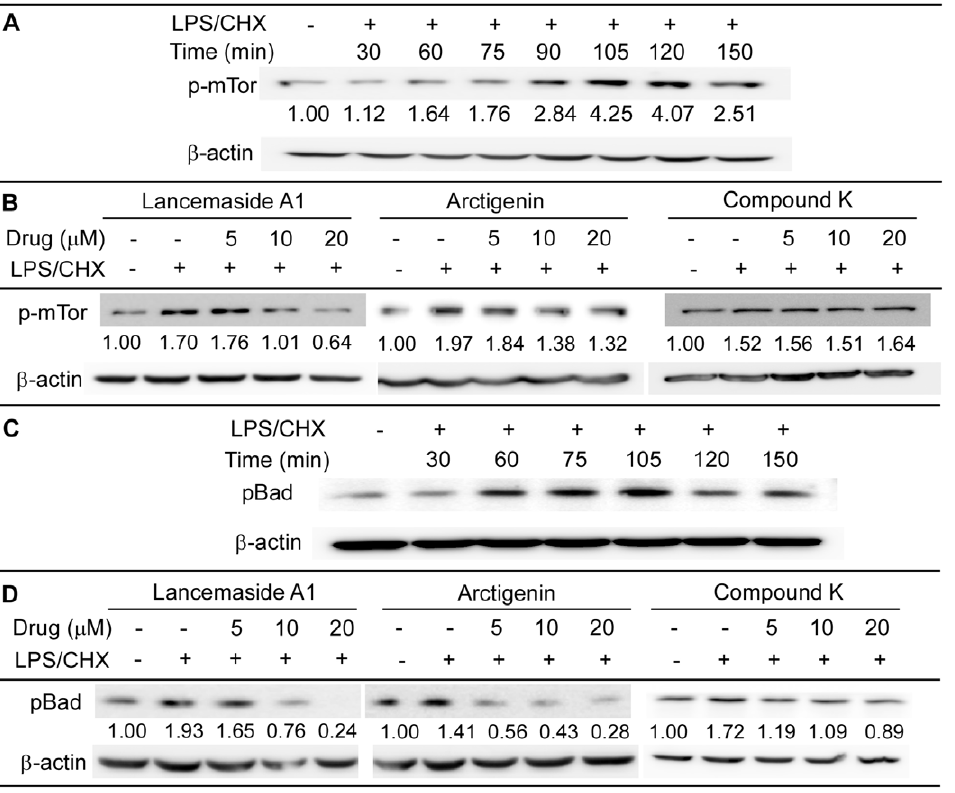
Figure 7. Evaluating the effects of the screened compounds on phosphorylation of mTOR and pBad. ( A ) A time course for mTor phosphorylation was done to optimize the assay. Maximum level of p-mTor was detected at 105 minutes after LPS/CHX treatment. ( B ) p-mTor level in Tat-expressing CHME5 cell lysates from different treatment conditions were examined at 105 minutes, and levels of p-mTor were normalized to b - actin. Averages of the data are shown below each blot. ( C ) Time course Bad phosphorylation was determined to optimize the assay, and maximum level of pBad was also detected at 105 minutes after LPS/CHX treatment. ( D ) pBad level in Tat-expressing CHME5 cell lysates from different treatment conditions were examined at 105 minutes, and levels of p-Bad were analyzed as described for